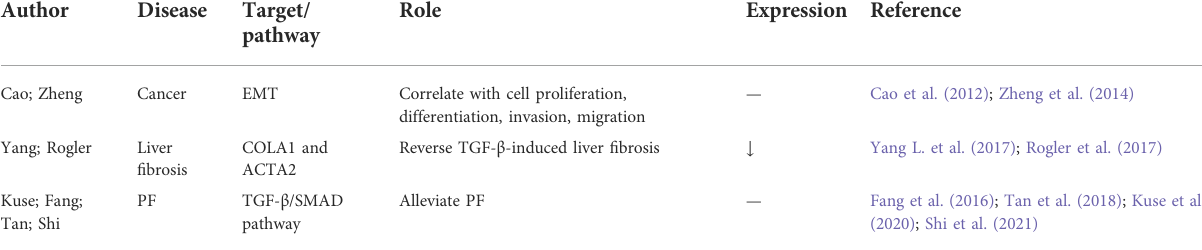
TABLE 10 The roles of let-7d-5p in lung